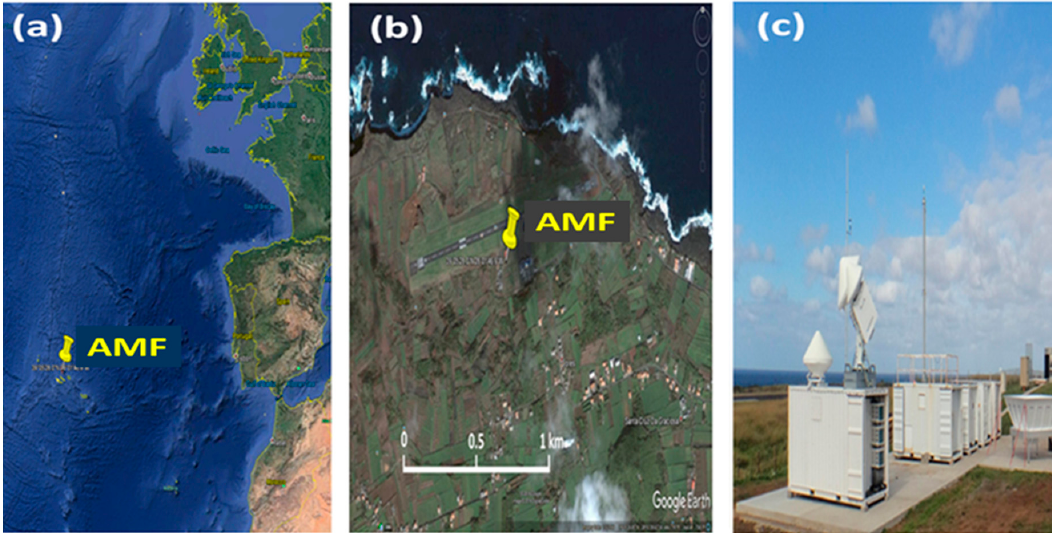
Figure 1. Aerial ( a , b ) and surface ( c ) images of the Atmospheric Radiation Measurement (ARM) Program Mobile Facility (AMF) site. The aerial and surface images are taken from Google Earth and website [18], respectively. These two images indicate the locations of the ground-based instrumentation suite, which includes the Multi-Filter Rotating Shadowband Radiometer (MFRSR). The suite is surrounded by several sub-areas with different surface types, such as “brown” soil, “green” vegetation and “navy” ocean with